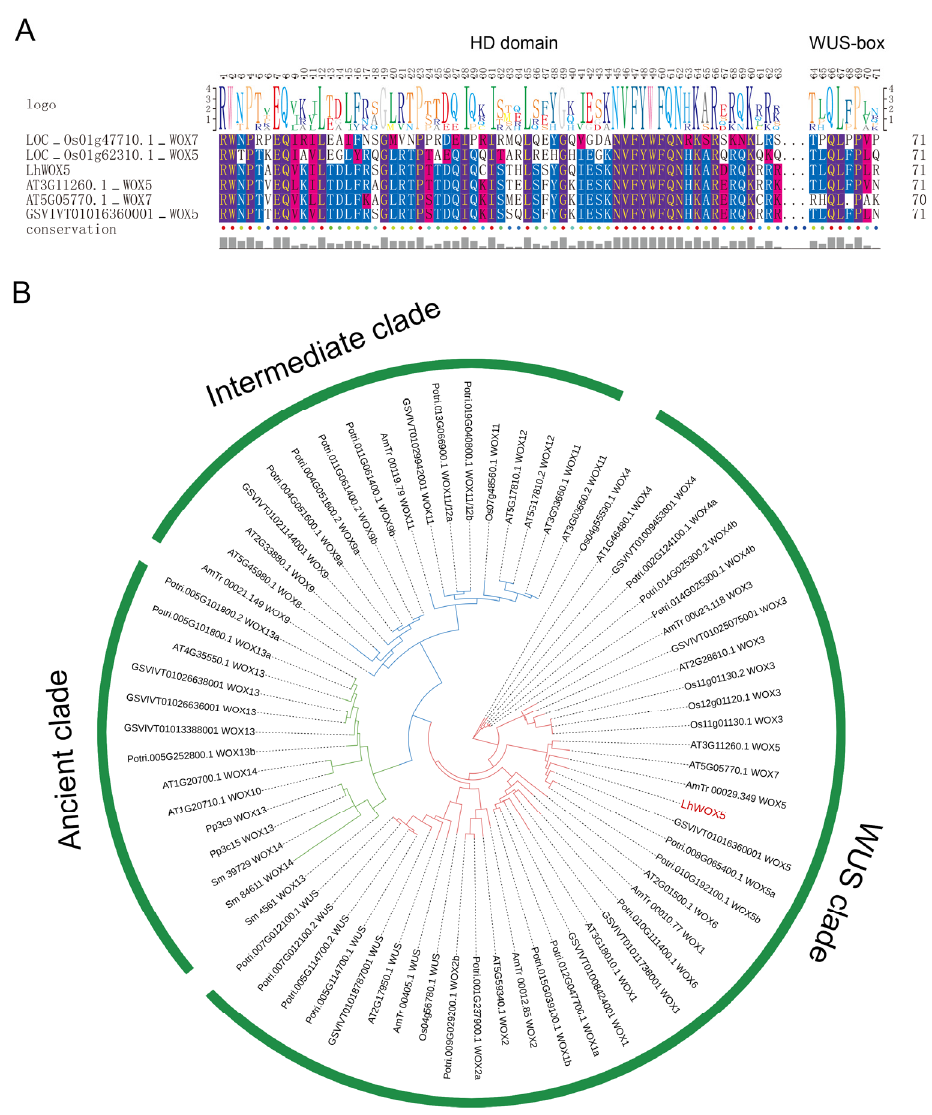
Figure 1. The identification of LhWOX5 in Liriodendron hybrids. ( A ) Protein sequences from Arabidopsis thaliana (AT3G11260.1_WOX5 and AT5G05770.1_WOX7), Amborella trichopoda (AmTr_00029.349_WOX5), Vitis vinifera (GSVIVT01016360001_WOX5), and Oryza sativa (LOC_Os01g62310.1_WOX5 and LOC_Os01g47710.1_WOX7) were aligned. The conserved Homeodomain (HD domain) [1] and WUS-box [2] are shown. ( B ) Phylogeny of the WOX gene family from various species. WOX genes from Arabidopsis thaliana , Amborella trichopoda, Selaginella moellendorffii , Physcomitrella patens subsp. patens , Populus trichocarpa , and Vitis vinifera were used to construct the phylogenetic tree.